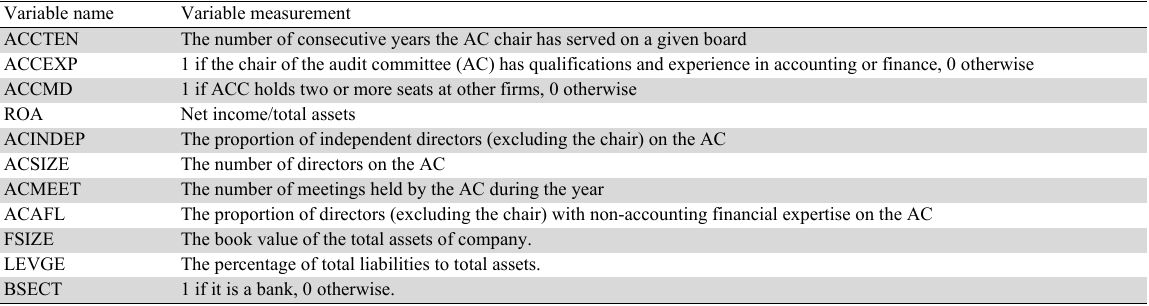
Summary of the operationalization of the